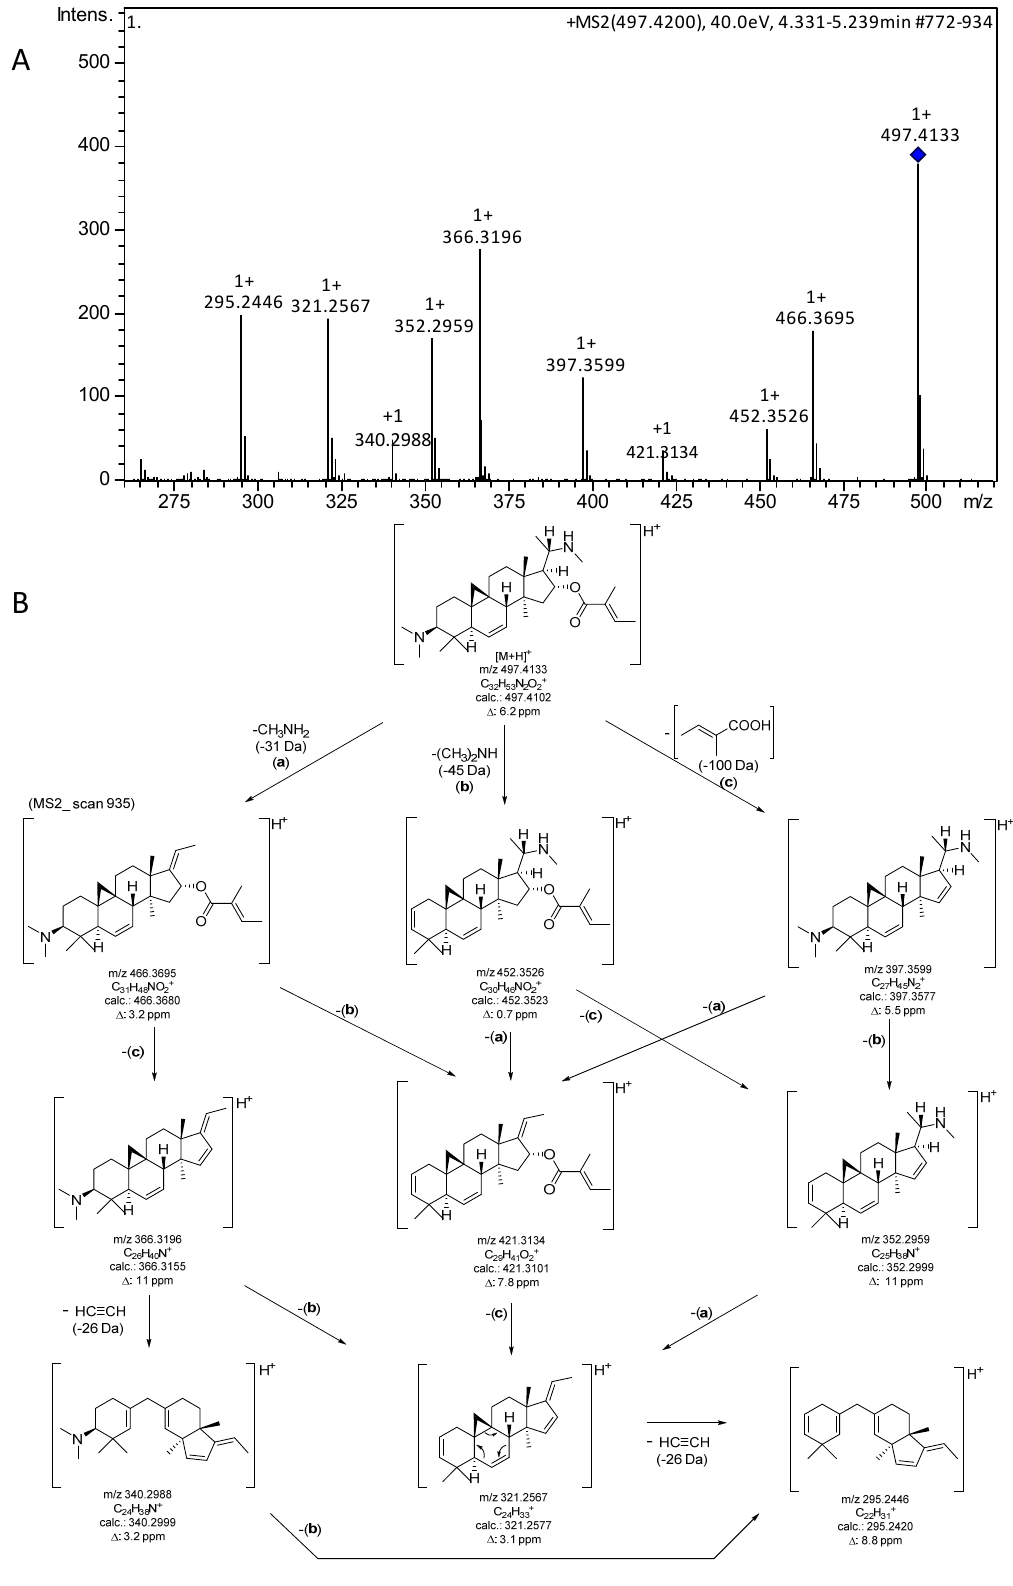
Figure 5. A: +ESI MS/MS spectrum (CID 40 eV; only the region for Figure 5 B is shown; the full Figure 5. ( A ) + ESI MS / MS spectrum (CID 40 eV; only the region for Figure 5B is shown; the full spectrum spectrum is presented in Figure S8, Supplementary Materials). B: Fragments and possible is presented in Figure S8, Supplementary Materials). ( B ) Fragments and possible fragmentation pathway fragmentation pathway of the [M + H] + ion of O-tigloylcyclovirobuxeine-B ( 1 ). of the [M + H] + ion of O-tigloylcyclovirobuxeine-B ( 1